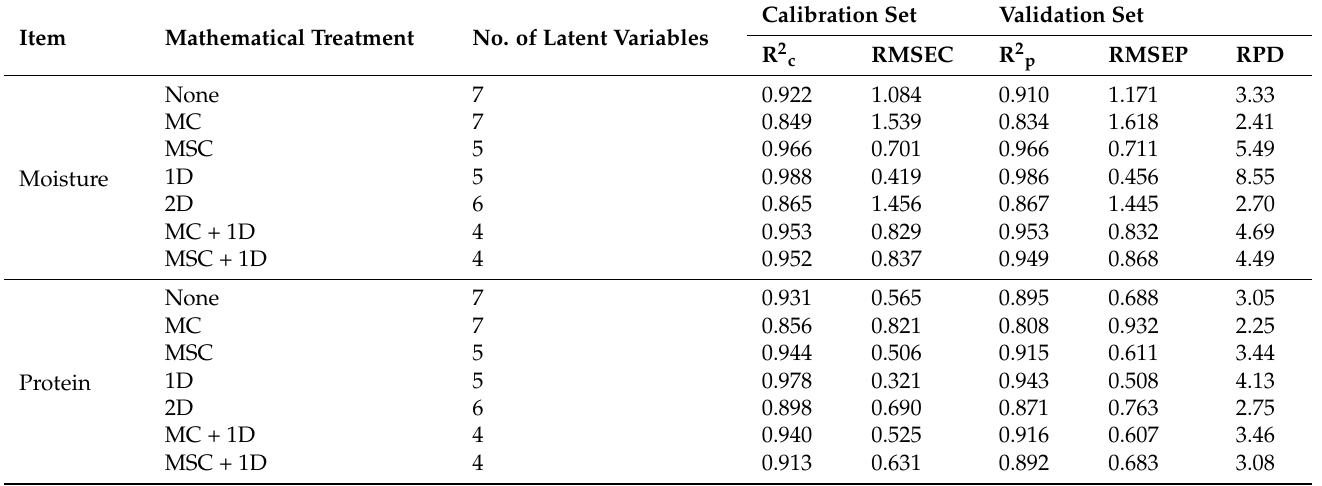
Table 5. Statistics of prediction models for moisture and protein content in living mealworm larvae by NIRS (1100–2100